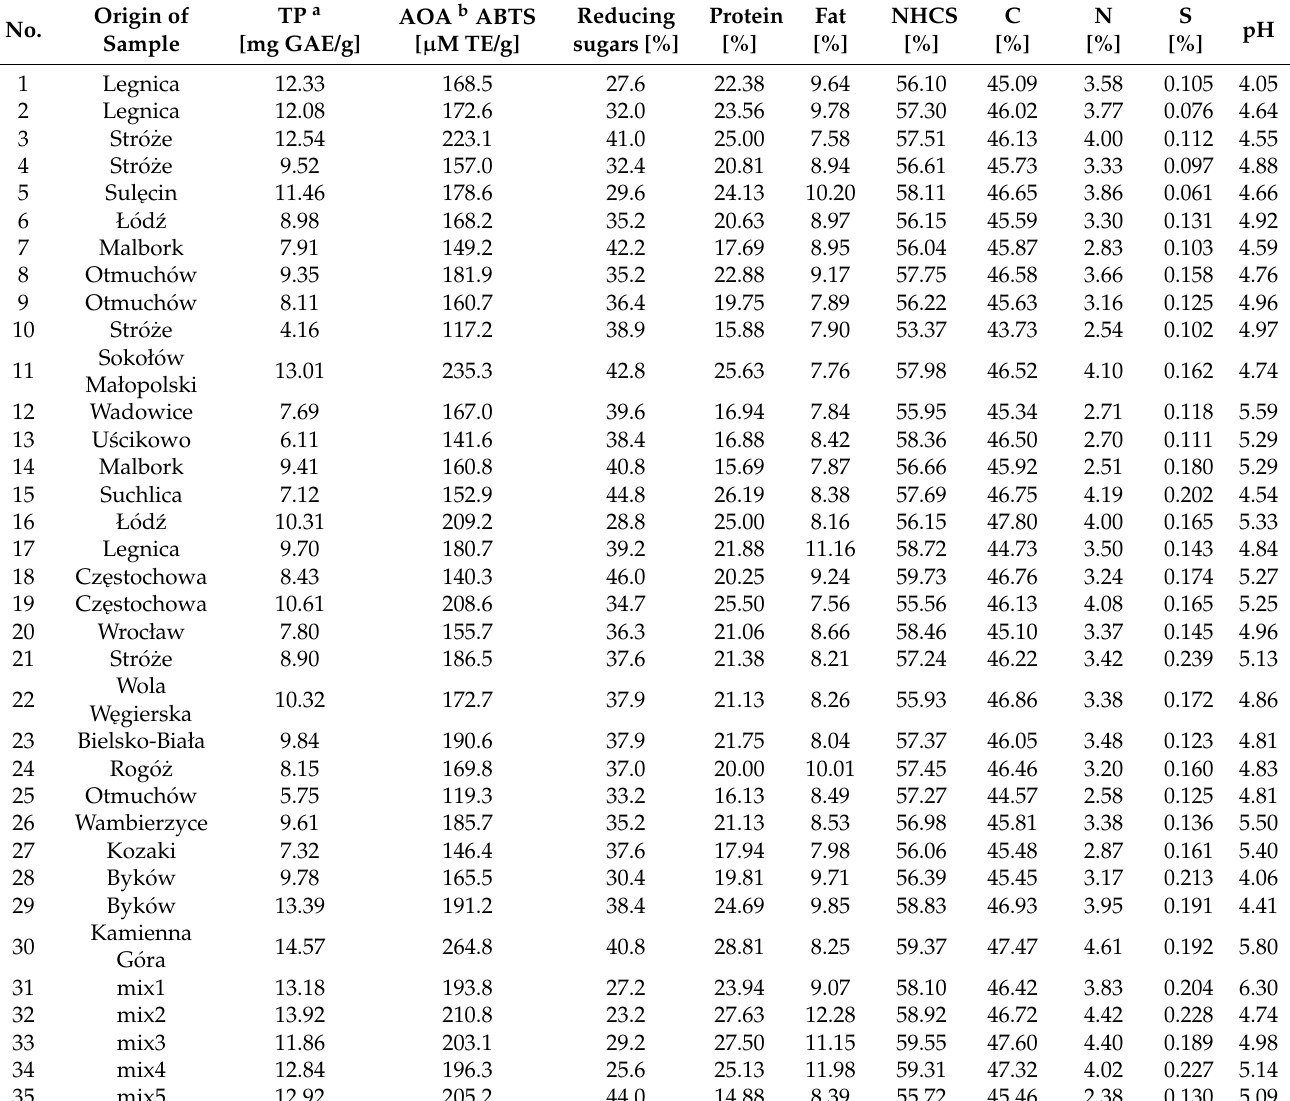
Table 1. Characteristics of the studied bee pollen